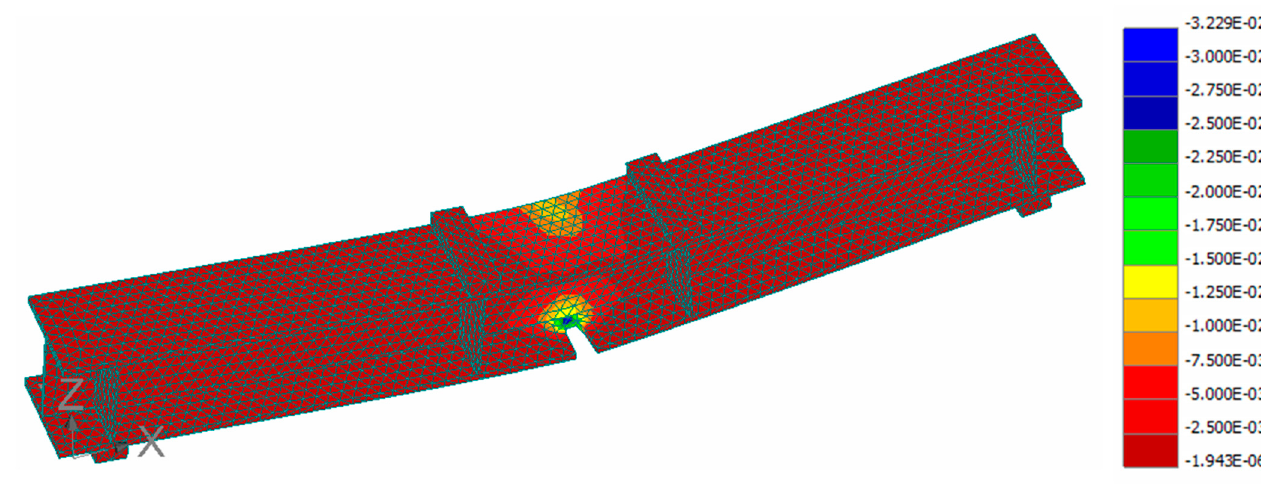
Figure 10. Similar failure modes in tests and FE models.